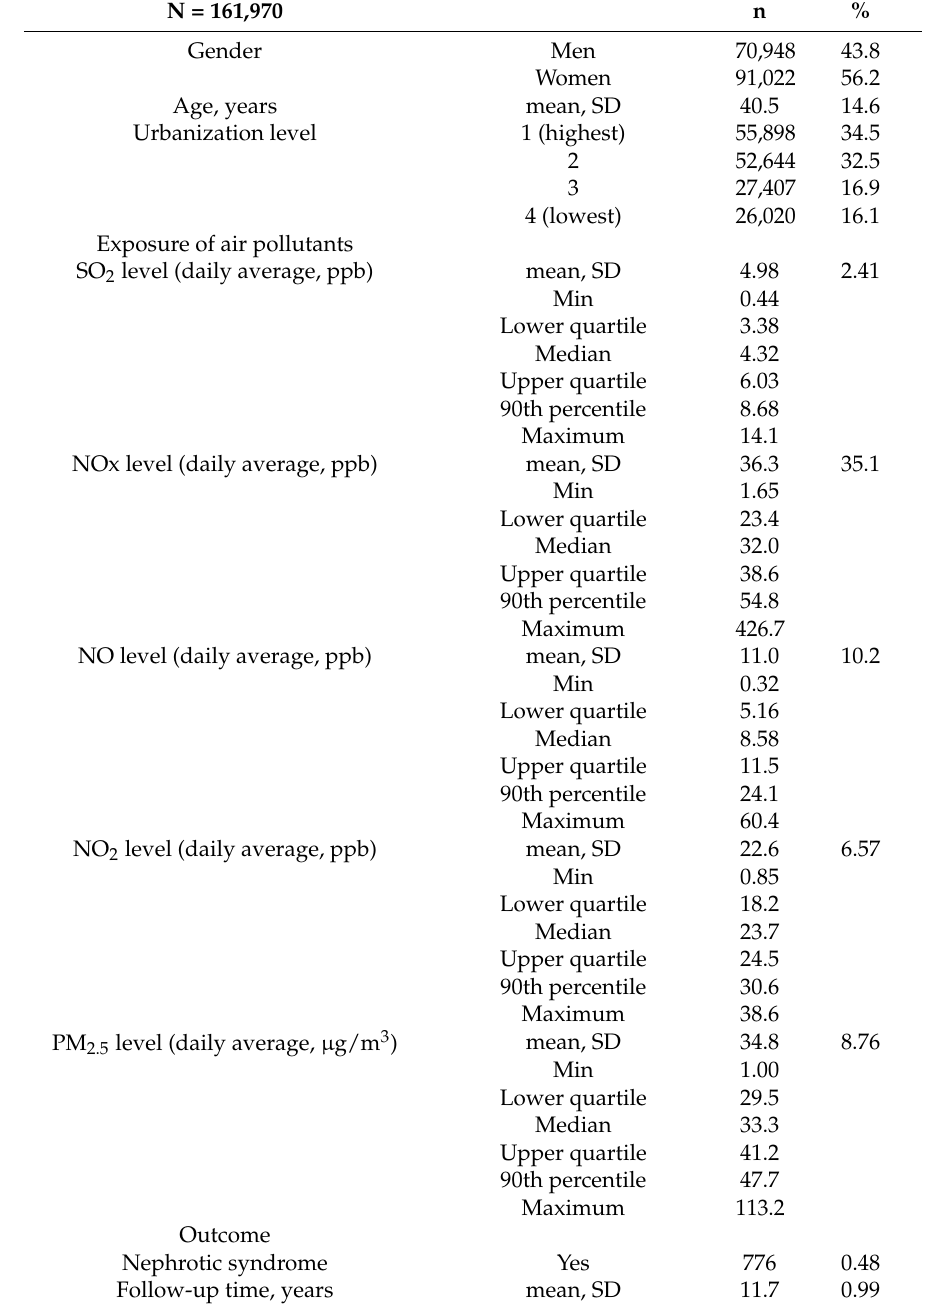
Table 1. Baseline demographics and exposure of air pollutants in